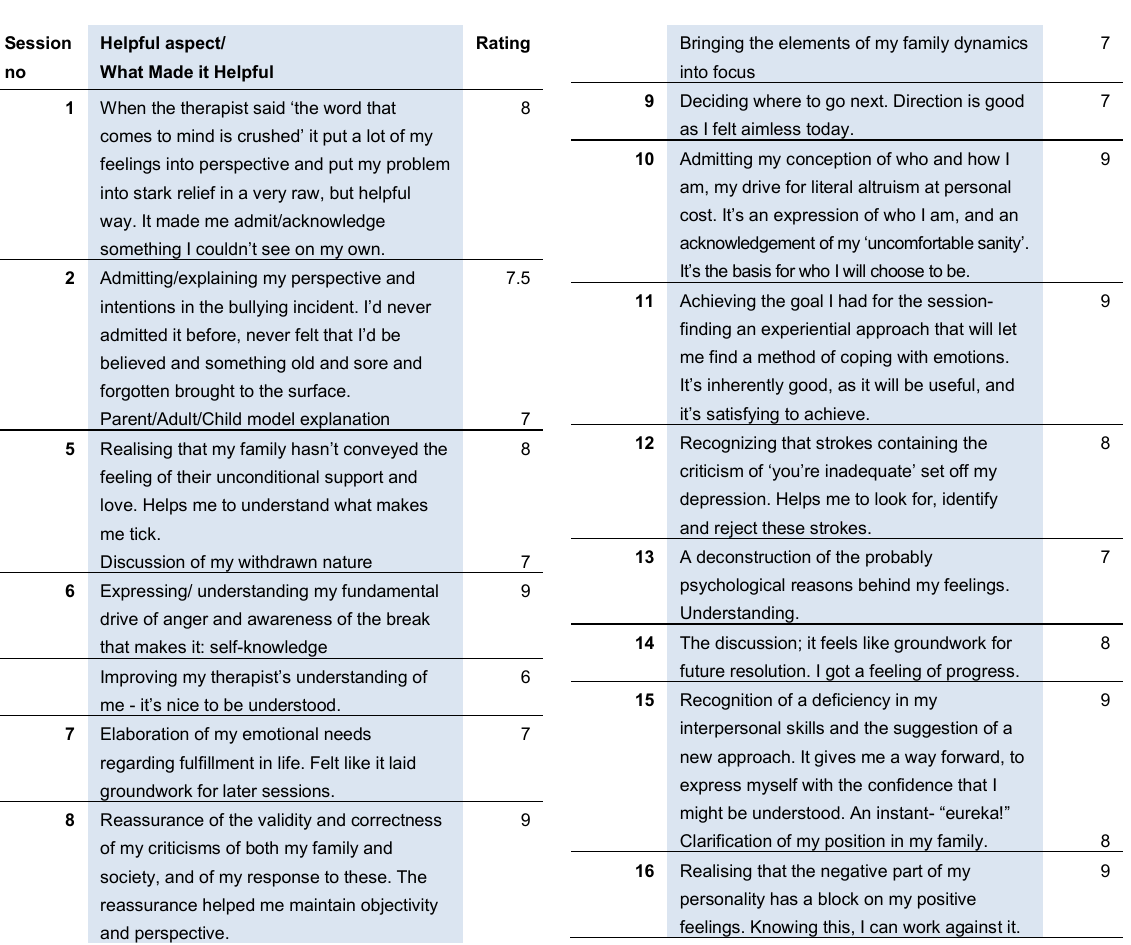
Table 6: Helpful Aspects of Therapy Rating key: Extremely (9); Greatly (8) or Moderately (7)